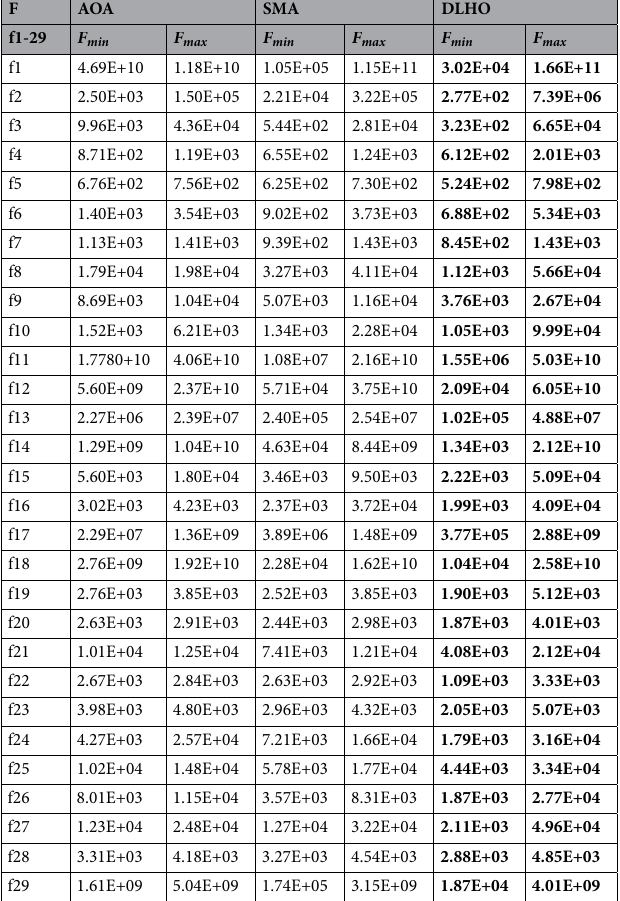
Table 4. Results of Optimizers on Hybrid and Composite test